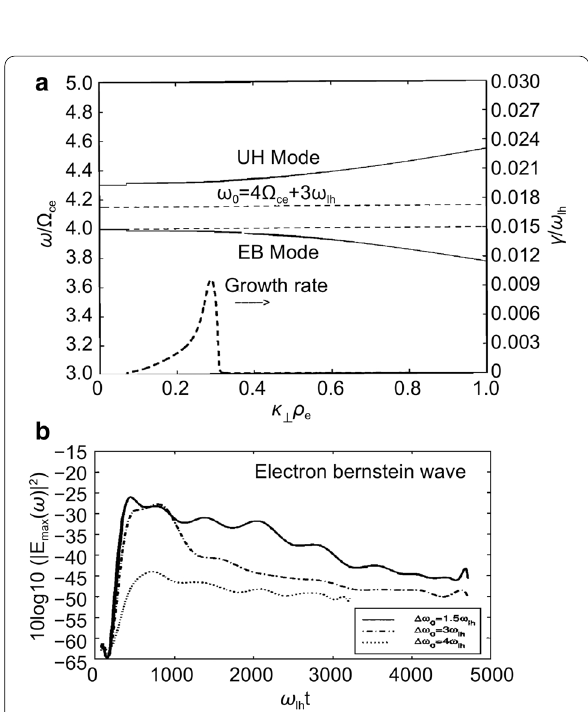
decay to the preheated value.